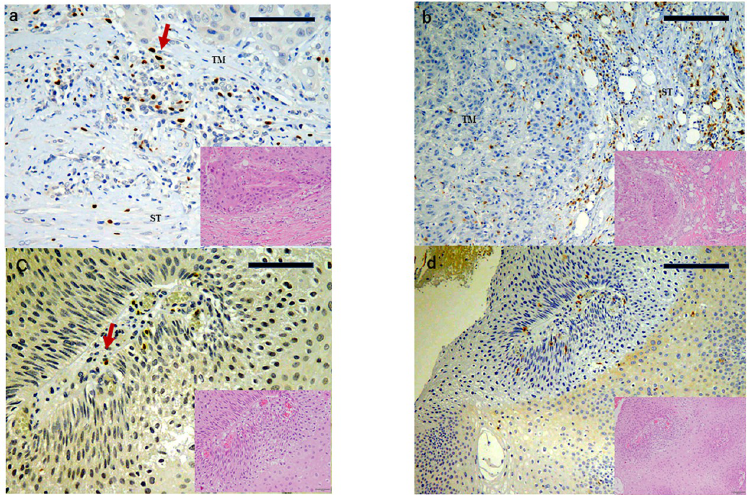
Fig 1. FOXP3 and CD8 expression in conjunctival SCC tumor tissue. (a) Strong FOXP3 staining in tumor and tumor stroma in invasive case(score: 3) (scale bar: 50 μ m). (b) Strong CD8 staining in the tumor stroma in invasive case (score: 3) (scale bar: 100 μ m). (c) Weak FOXP3 staining in carcinoma in situ case(score: 1) (scale bar: 50 μ m). (d) Weak CD8 staining in tumor stroma in carcinoma in situ case (score: 3) (scale bar: 100 μ m). Red arrow in (b) denotes FOXP3-positive lymphocyte. TM: Tumor; ST: Tumor